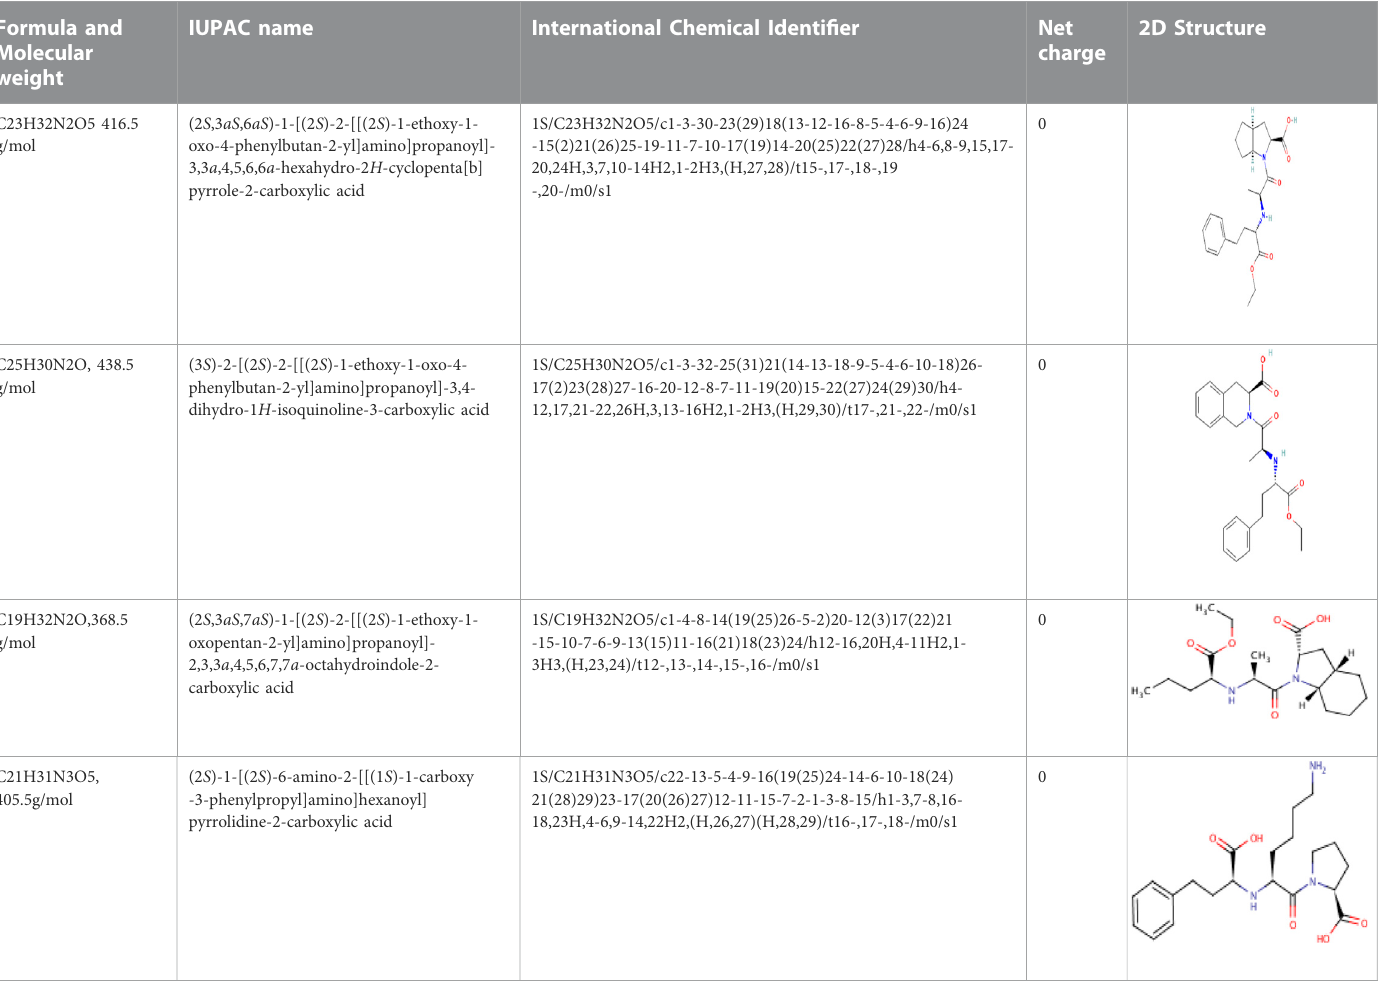
TABLE 2 ( Continued ) Molecular structural details of RAAS inhibitors (Ref: